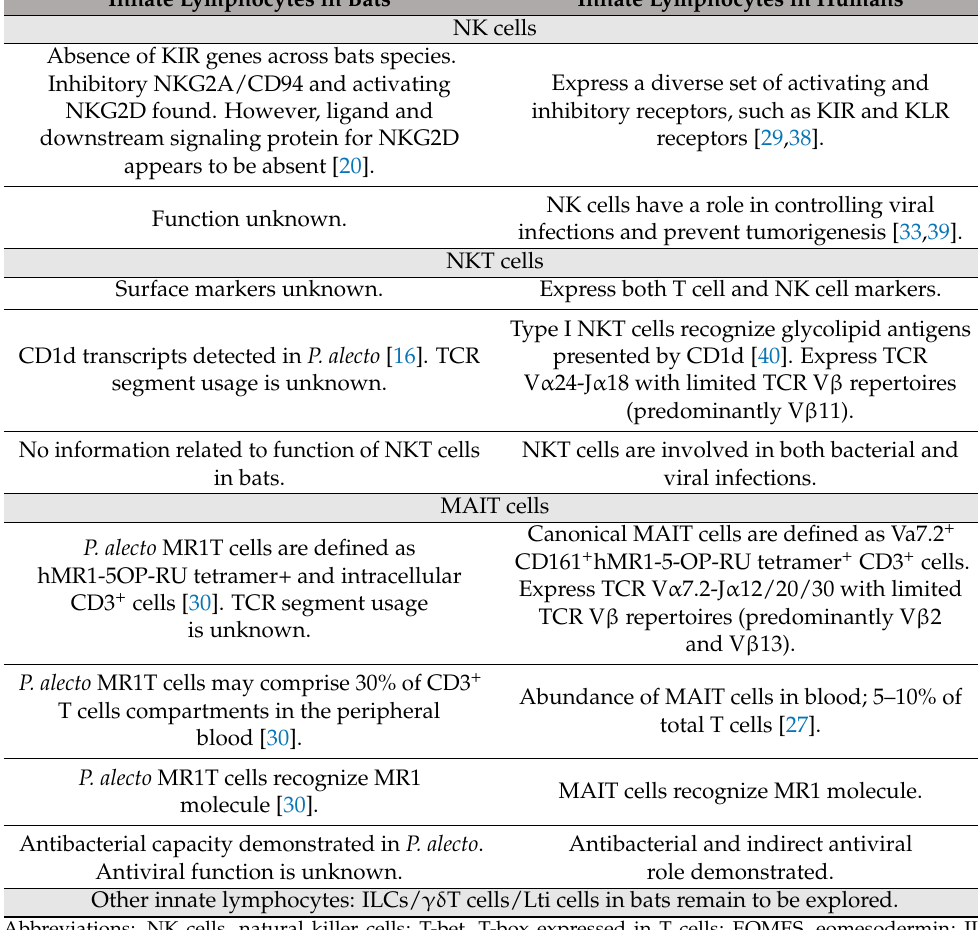
Table 1. Cont. Innate Lymphocytes in Bats Innate Lymphocytes in